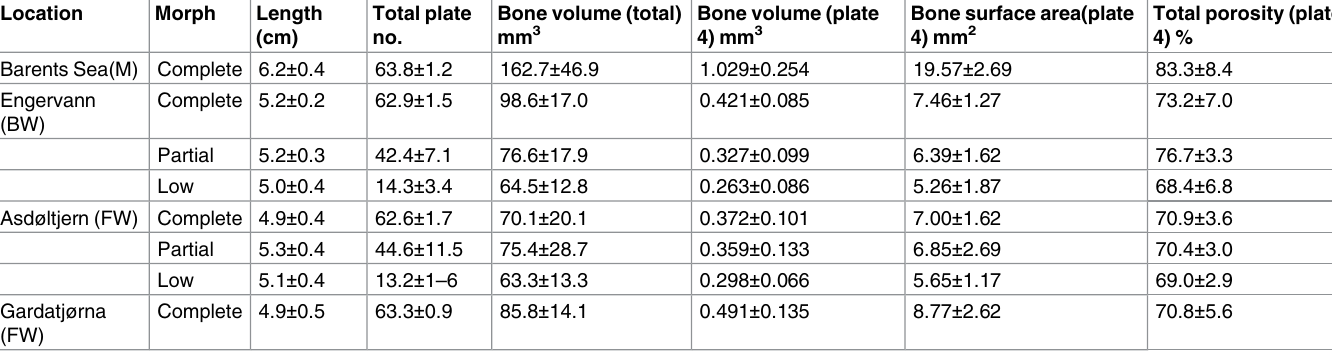
Table 1. Quality and size of lateral plates in threespine stickleback from marine (M), brackish water (BW) and freshwater (FW). Location Morph Barents Sea(M) Complete 6.2 ± 0.4